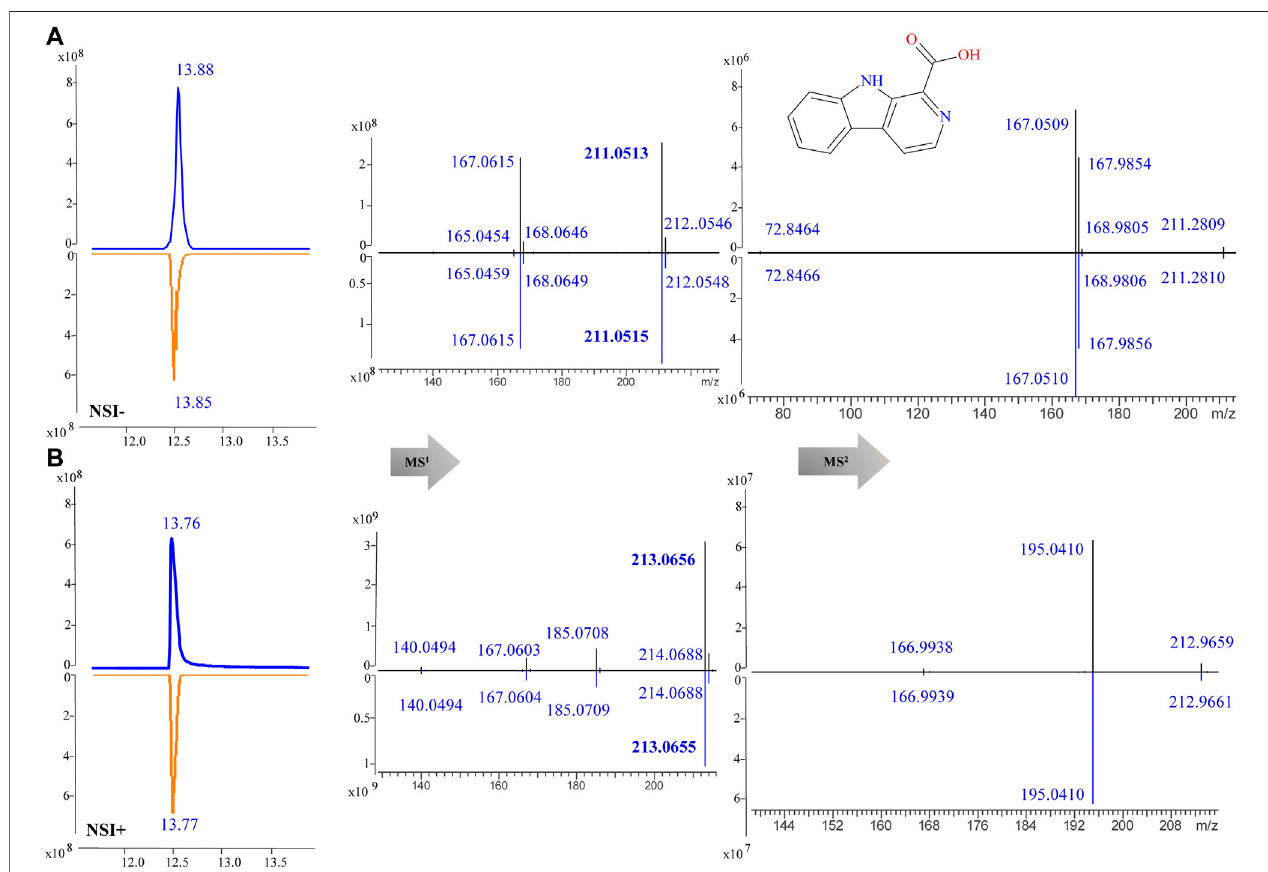
FIGURE 5 | MS 1 and MS 2 spectra of β -carboline-1-carboxylic acid (25) in the negative (NSI-) (A) and the positive (NSI+) (B) ion mode (upper panel: sample, lower panel: